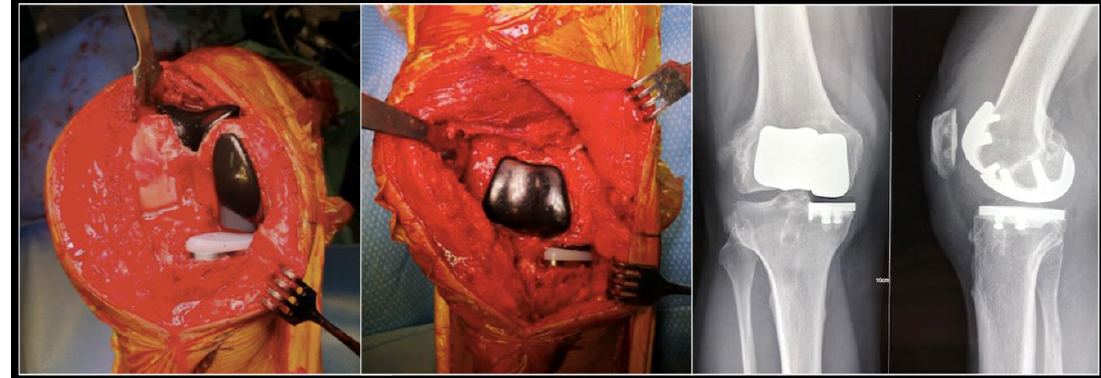
Figure 5. Per operative pictures and radiographs of a medial unicompartmental arthroplasty associated to a patellofemoral replacement in a young and active patient.